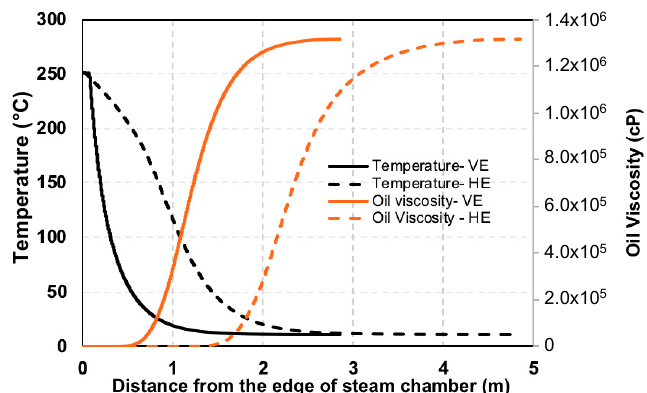
Figure 16. Oil viscosity and temperature profiles versus distance for VE and HE models.